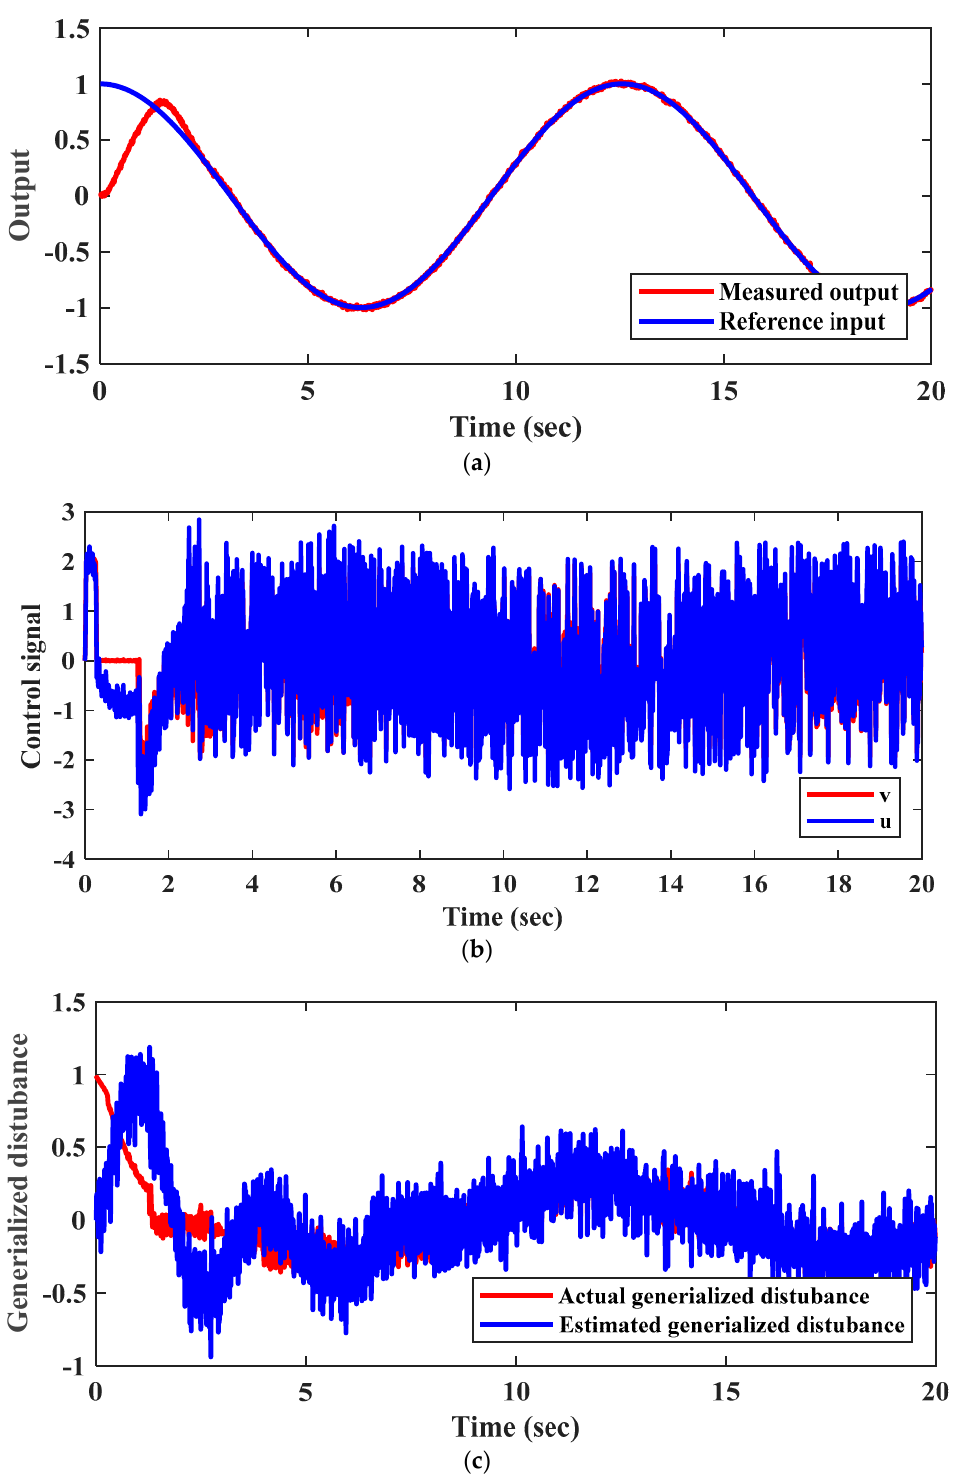
Figure 4. Results of the numerical simulation for Scenario 2, ( a ) tracking response y of the reference input r ; ( b ) control action u ; ( c ) estimation of the generalized disturbance ˆ ξ 3